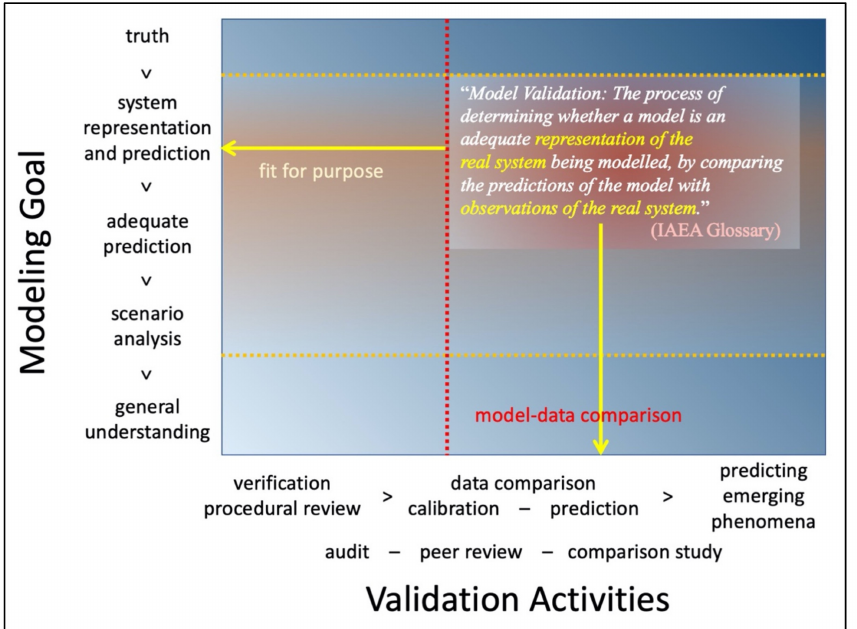
Figure 1. Approximate relation between validation activities needed to reach a particular validation goal. The yellow and red dotted lines indicate, respectively, the modeling goals and validation activities targeted by pragmatic model validation and the relation to the main goal and activity highlighted in the IAEA definition of model